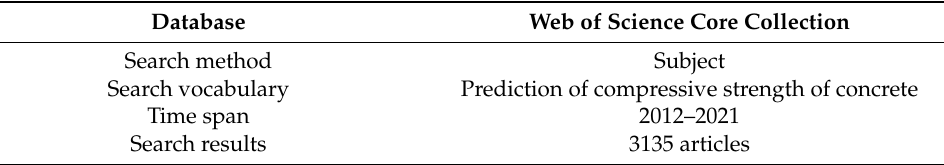
Table 1. Data Table 1. Data sources.